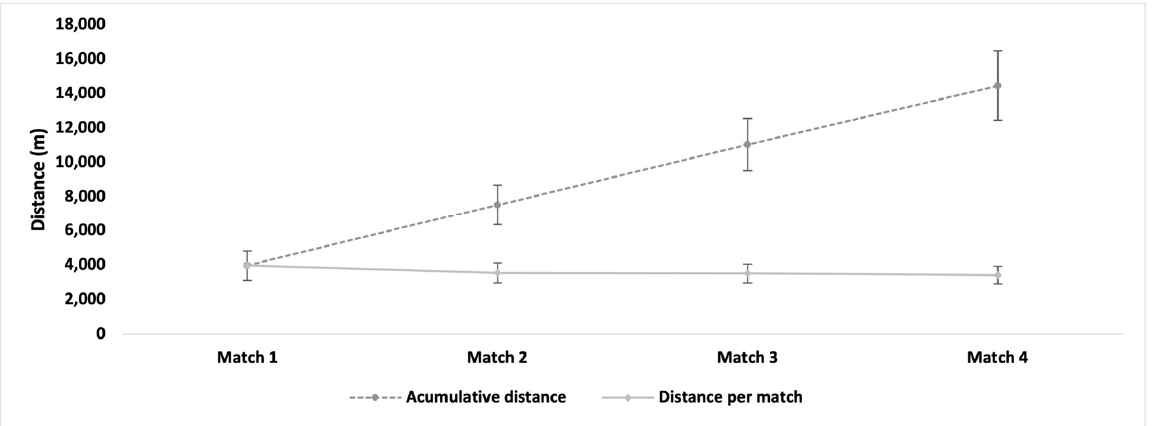
Figure 2. Accumulated distance per match and throughout successive matches. Lines denote the standard deviation. standard